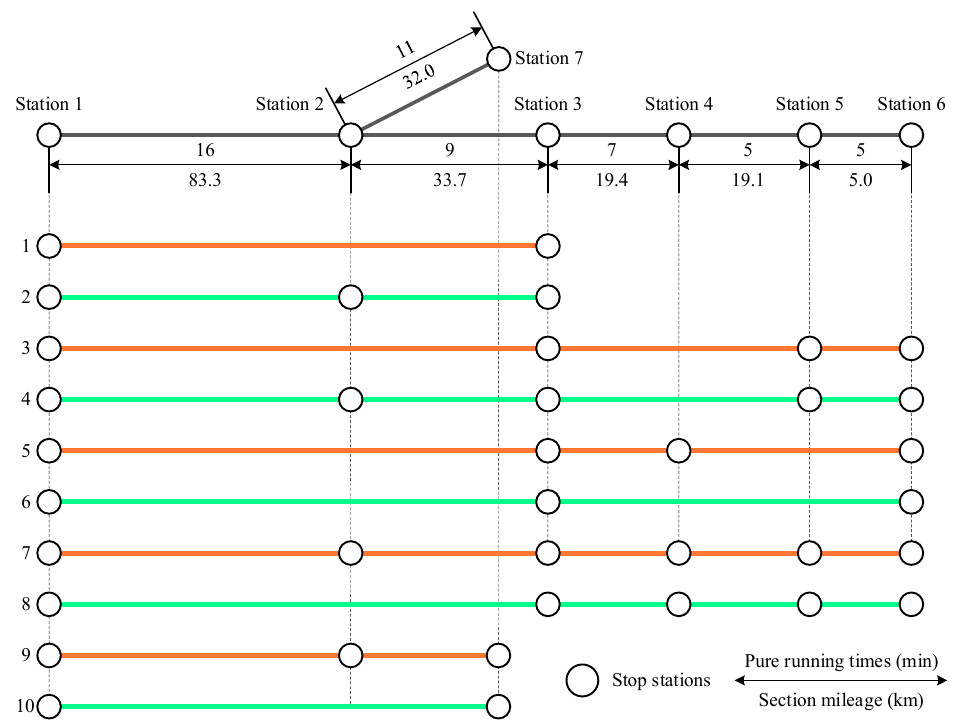
Figure 3. Railway network for experiments, where the colored lines represent optional lines. All stations (station 1 to station 7) are served and set 𝜚 (cid:2869) = 0.005 and 𝜚 (cid:2870) = 1.0. The solution of the model is based on Gurobi 9.5.2 and C# on the Visual Studio 2022 platform. Table 3. Lines in line plan.